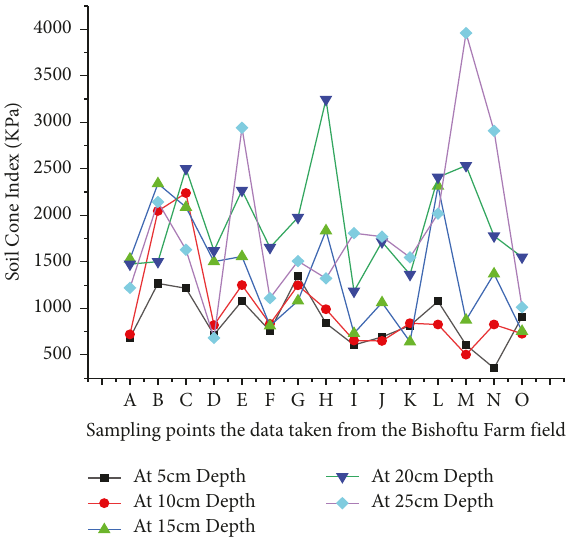
Figure 3: Soil cone index of all sample points vs. Table 1: Soil compaction correlation of within Bishoftu experimental field sites.